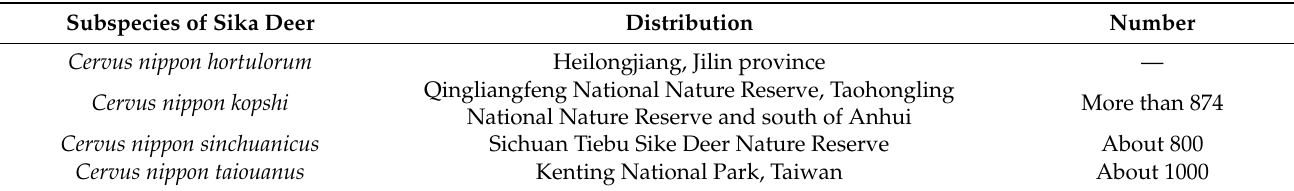
Table 1. Distribution and number of subspecies of wild sika deer.